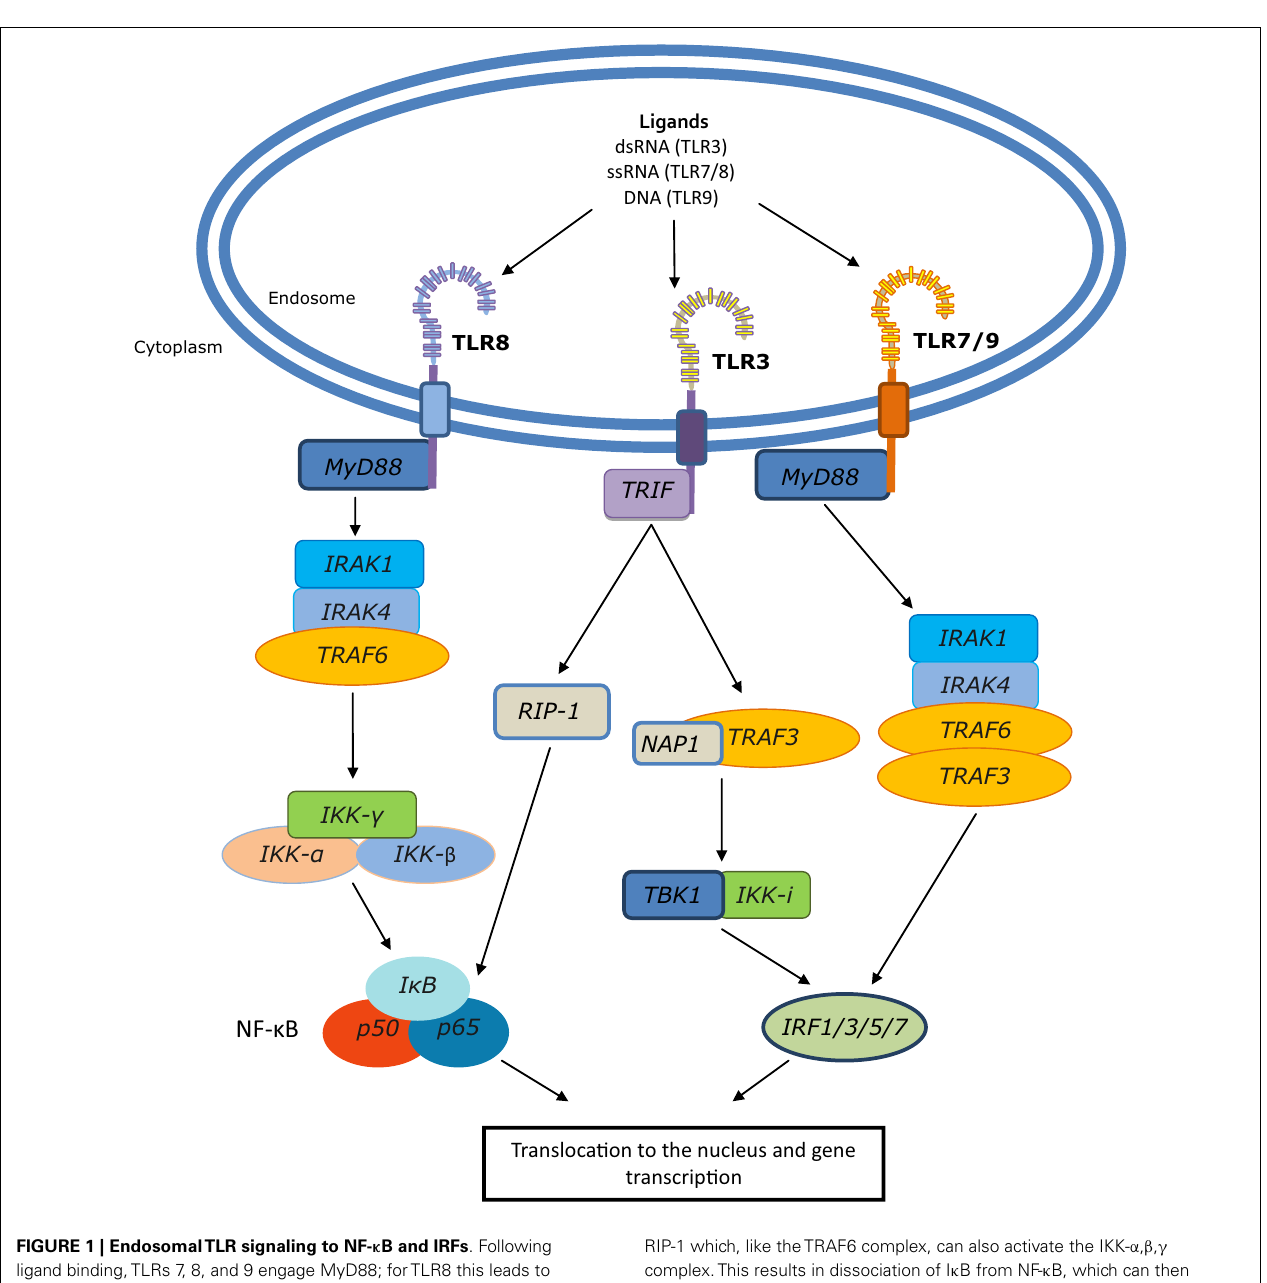
FIGURE 1 | EndosomalTLR signaling to NF- κ B and IRFs . Following ligand binding,TLRs 7, 8, and 9 engage MyD88; forTLR8 this leads to activation of NF- κ B, whereasTLRs 7 and 9 engage IRAK1/4,TRAF3, and TRAF6 to activate IRF family members.TLR3 uses theTLR adaptorTRIF, which can induce NF- κ B through theTRAF6 complex and can signal to